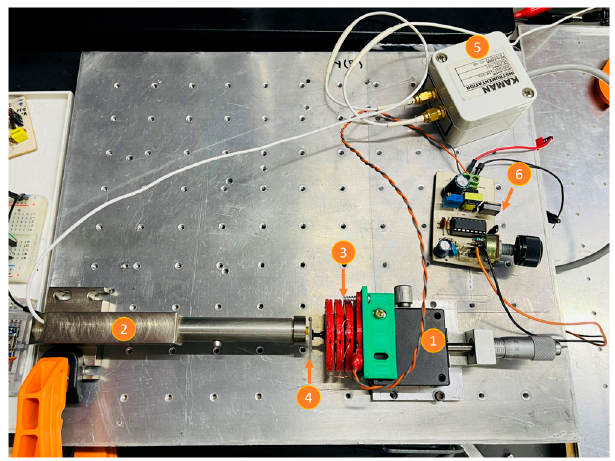
Figure 8. Experimental setup to measure the displacement generated by the piezoelectric stack. 1. Displacement platform. 2. Inductive sensor. 3. Piezoelectric stack. 4. Small square piece of reflective aluminum. 5. Control module. 6. Piezoelectric actuator driver.